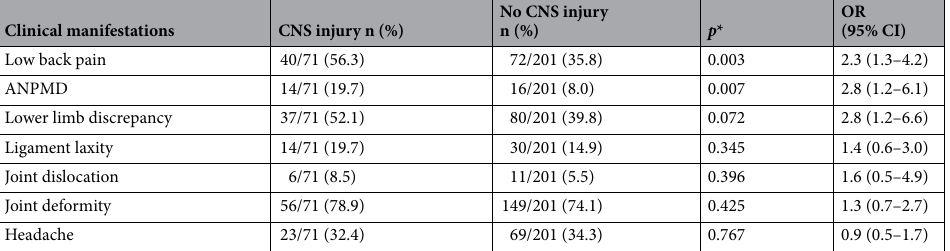
Table 4. Comparison of clinical manifestations between genetic skeletal disorder patients with and without CNS injury. CNS central nervous system, ANPMD abnormal neuropsychomotor development, OR odds ratio, CI confidence interval. *X 2 test or Fisher’s exact test.